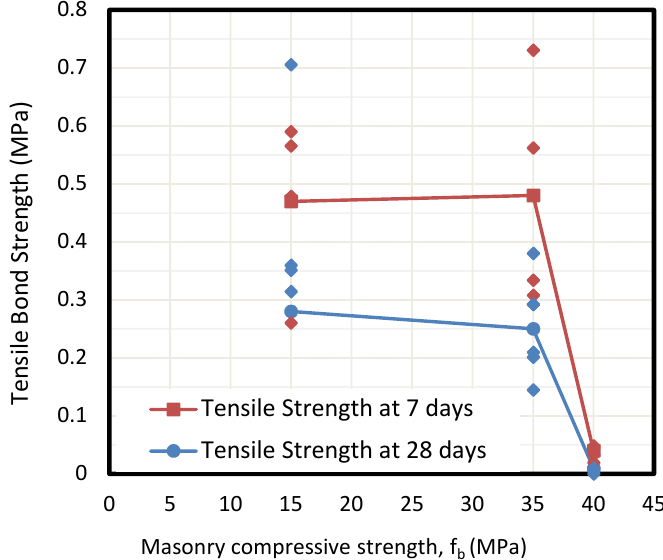
Figure 8. Calculated values of tensile bond strengths depending on bricks (fb) at different ages of mortar drying.